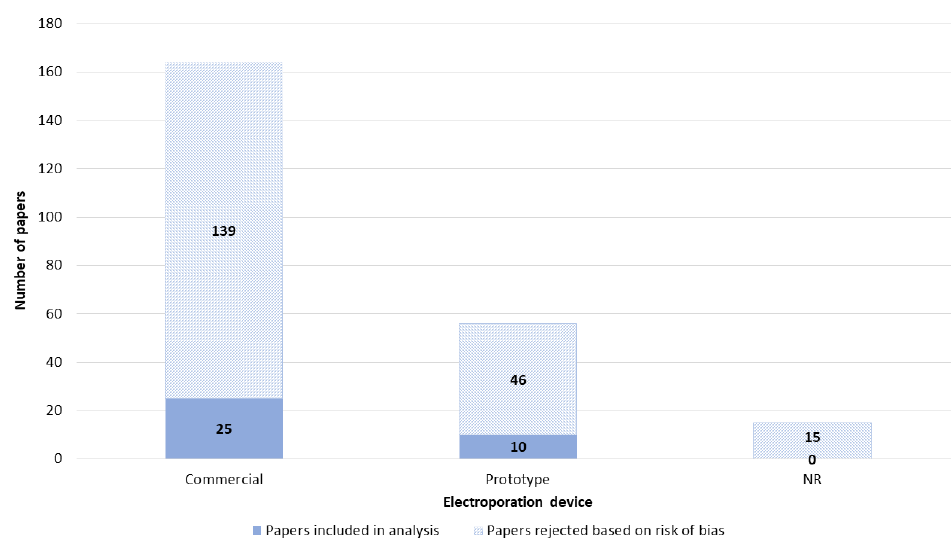
Figure 6. Electroporation device. NR—not reported. Figure 6.